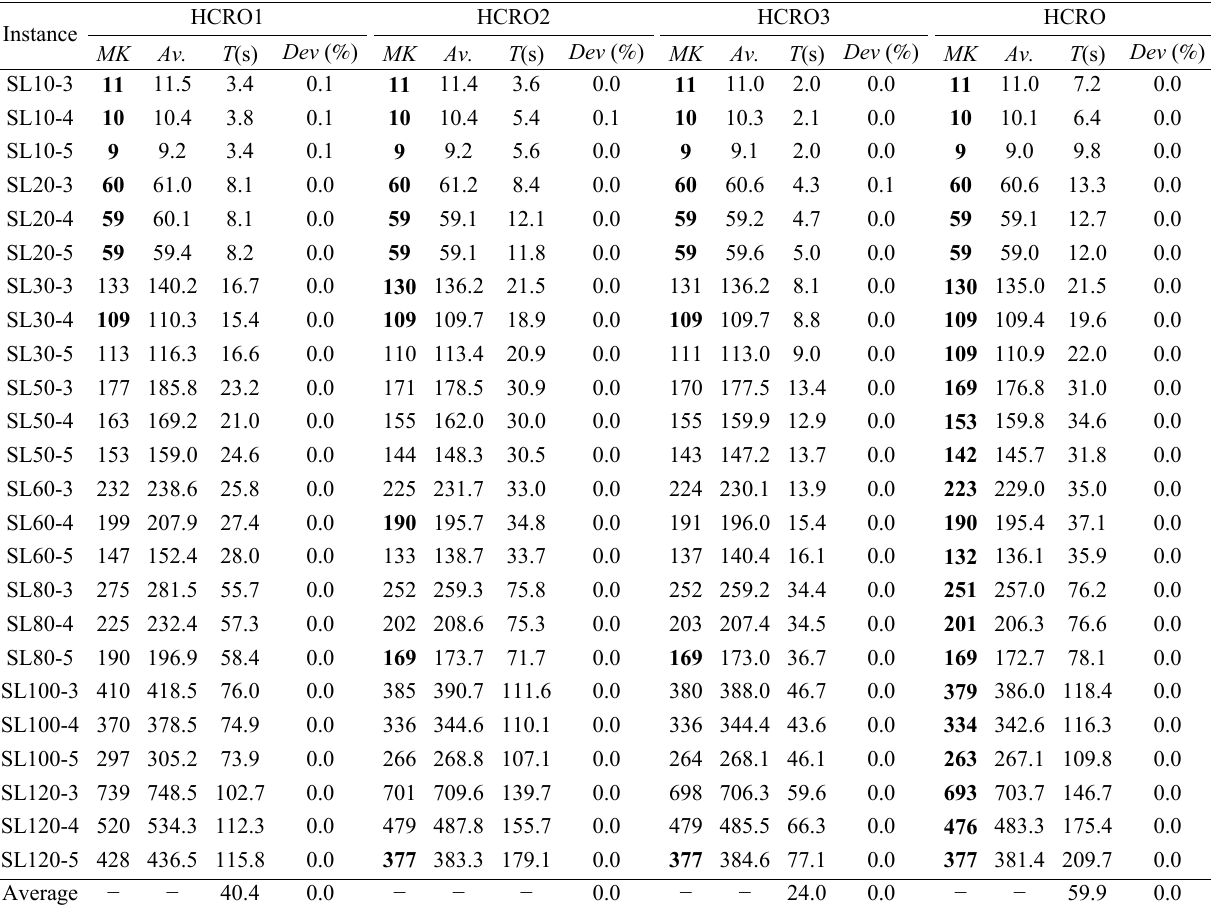
Table 10 Performance comparison of DFJSP in heterogeneous FMUs in Experiment